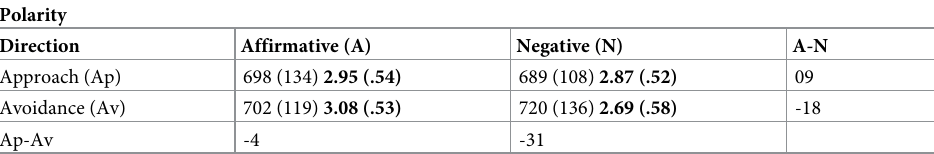
Table 3. Means and standard deviations (in parenthesis) of recognition task latencies for correct responses as a function of Direction and Polarity (delay of 1500 ms). Imaginability scores of sentences are placed in bold under each